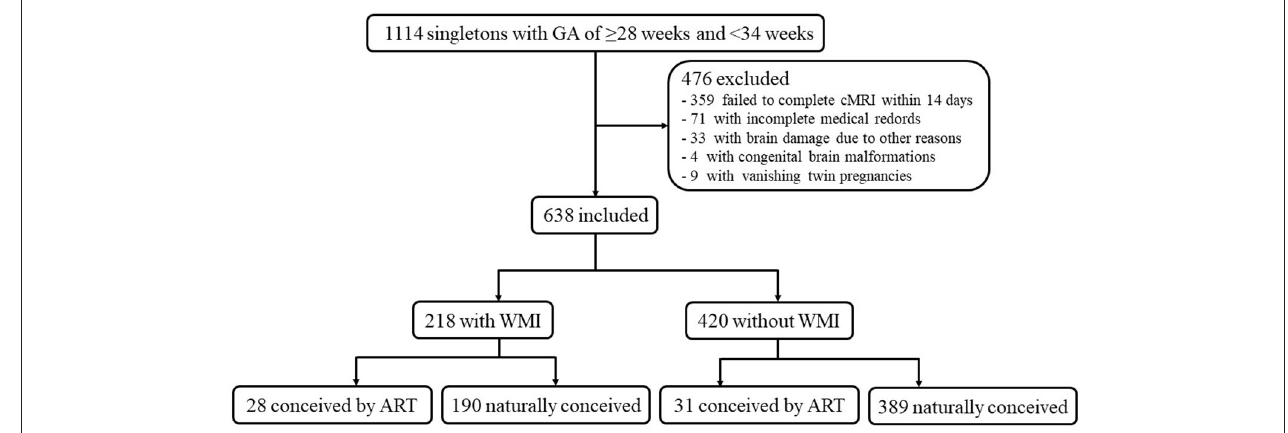
FIGURE 1 | Participant